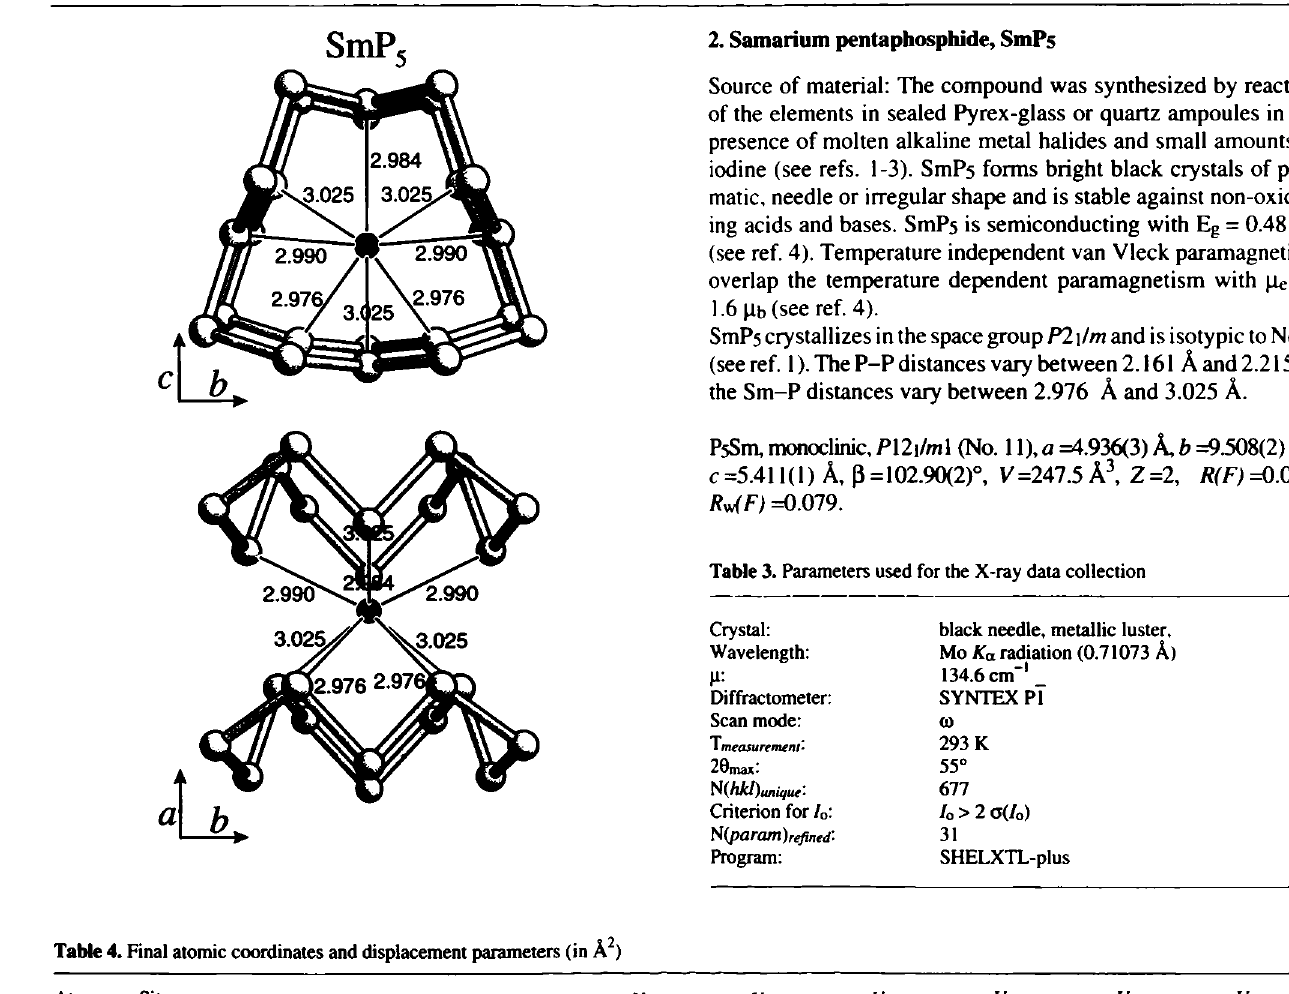
Table 4. Final atomic coordinates and displacement parameters (in Â^) Atom